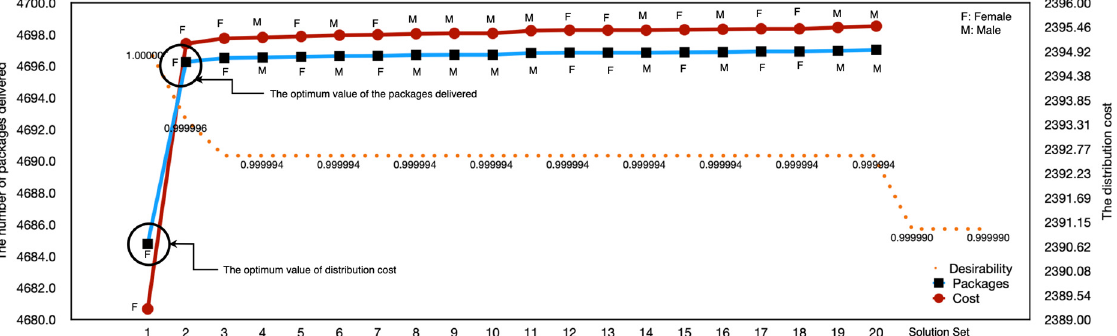
Figure 7. Optimum values of the number of packages distributed and distribution cost depending on the desirability values. the desirability